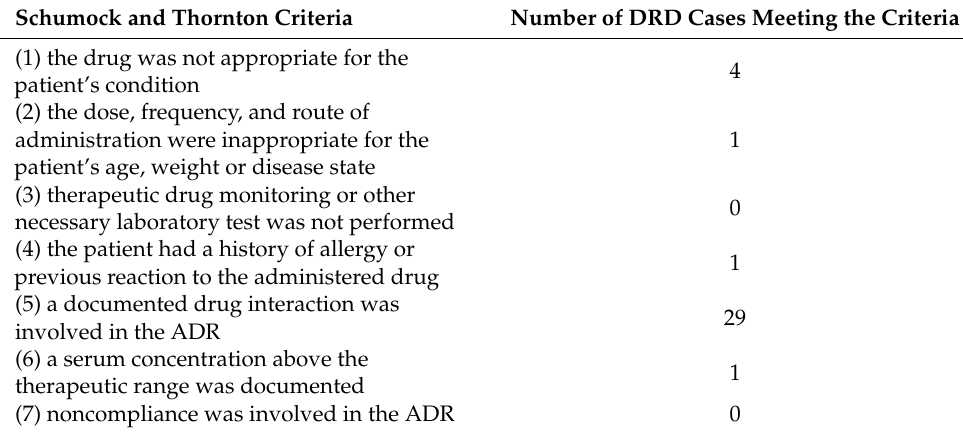
Table 8. Frequency of DRD cases meeting the Schumock and Thornton